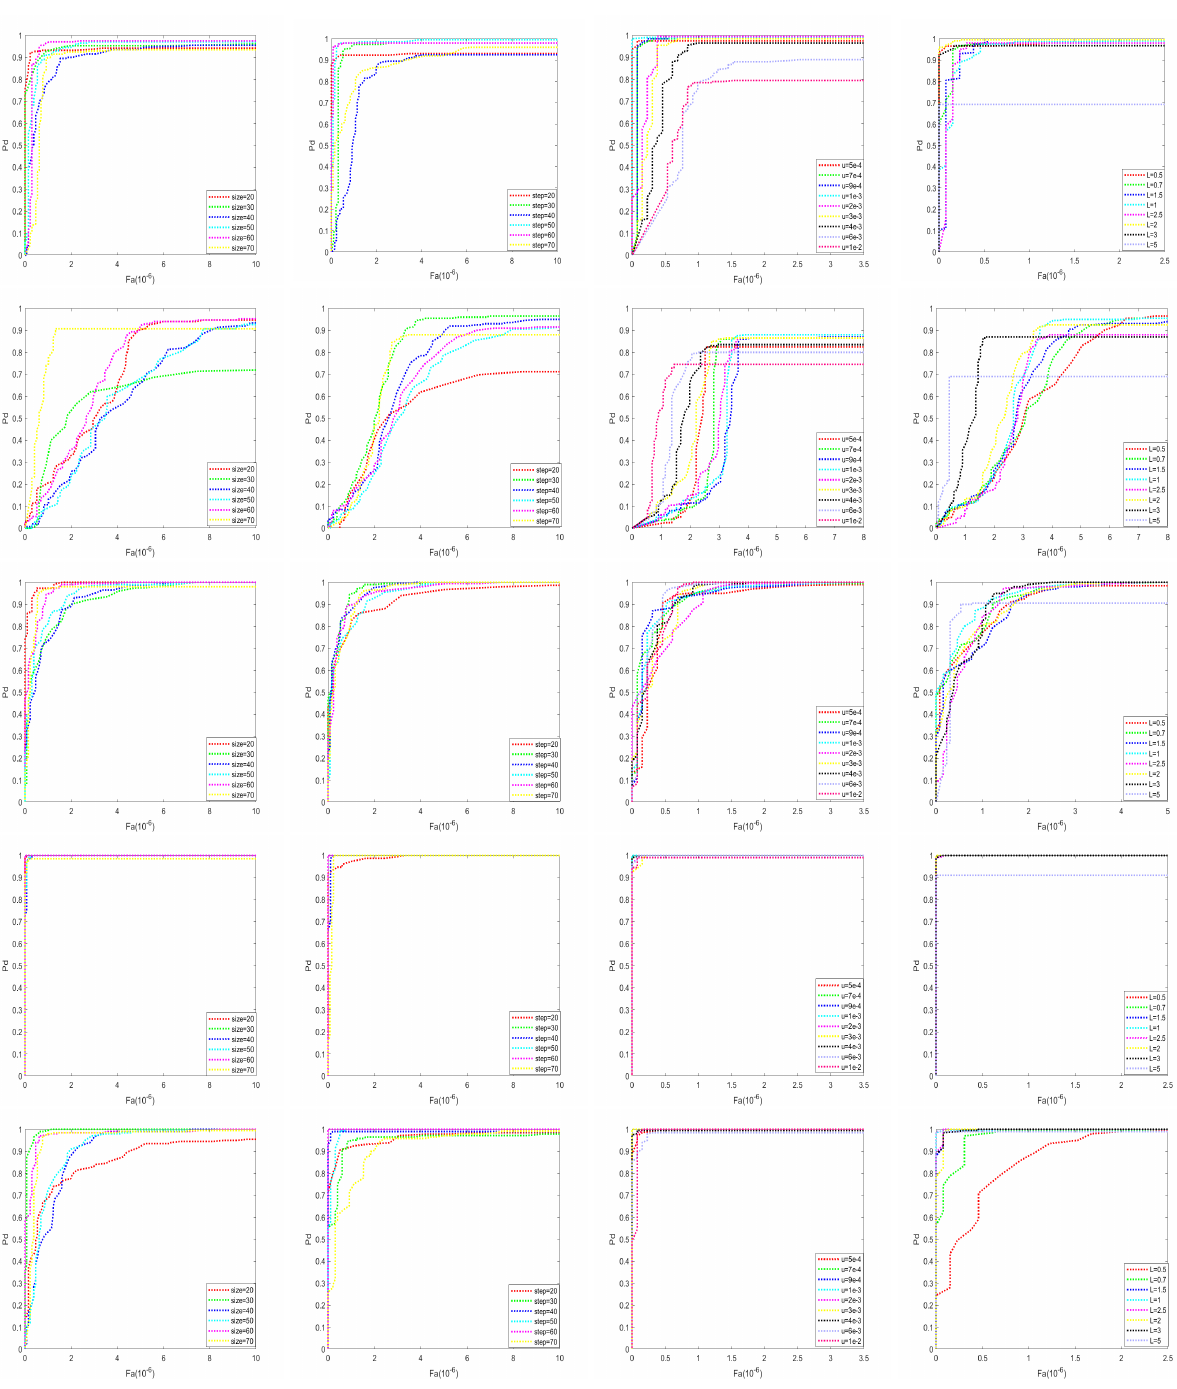
Figure 11. The ROC curves formed under different parameters. The first column is the influence of the patch sizes. The second column is the influence of different sliding steps. The third column is the influence of the penalty factor µ . The fourth column is the influence of the trade-off factor λ . Each row represents different parameters in the same